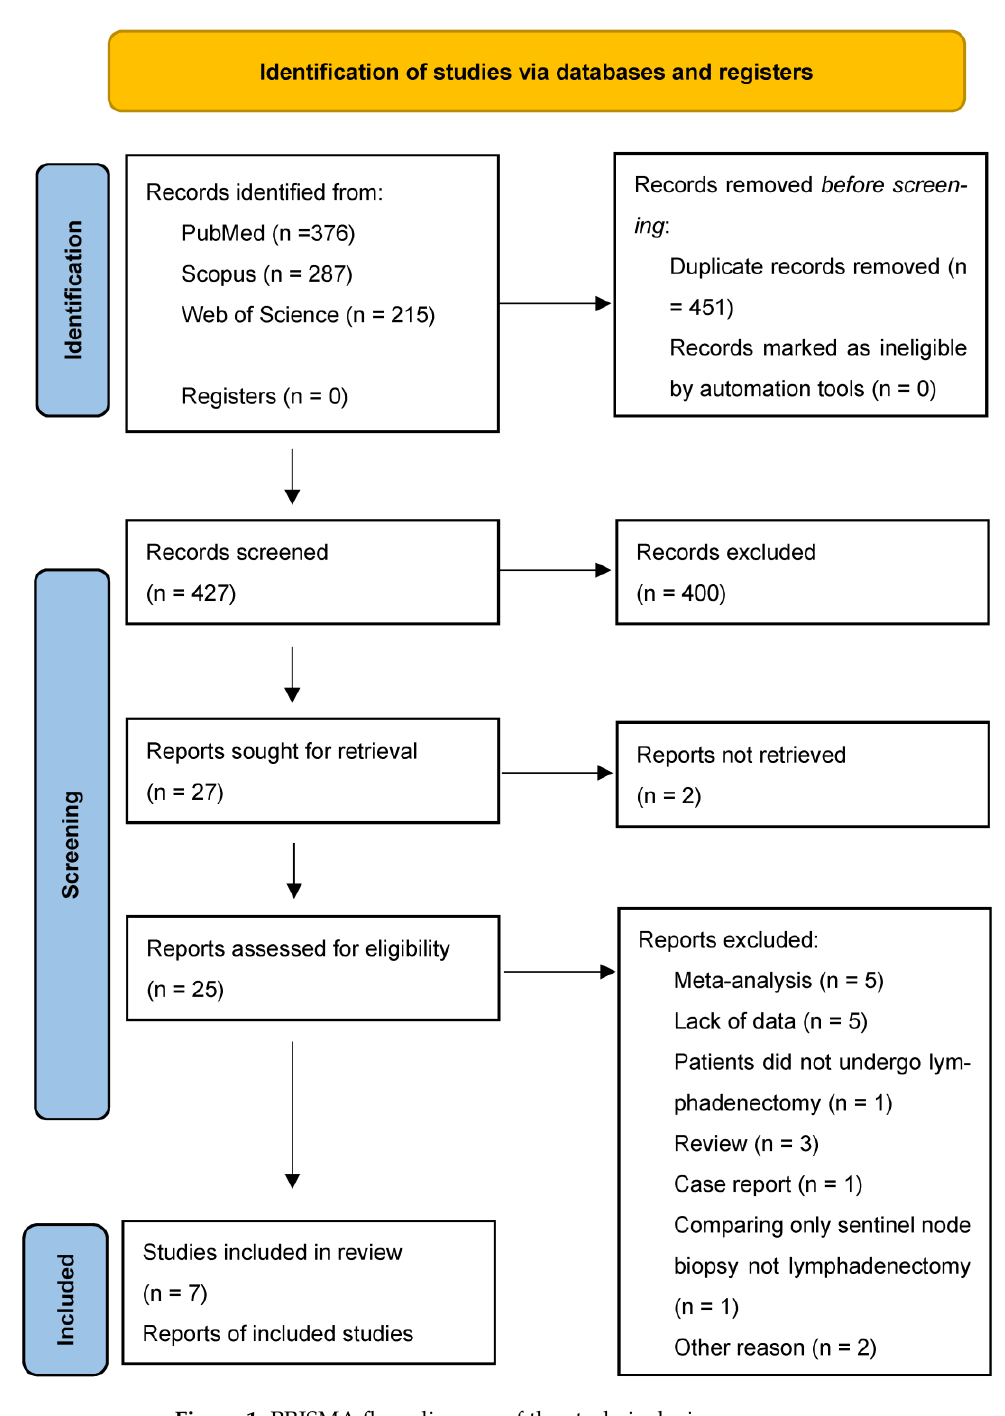
Figure 1. PRISMA flow-diagram of the study inclusion process.